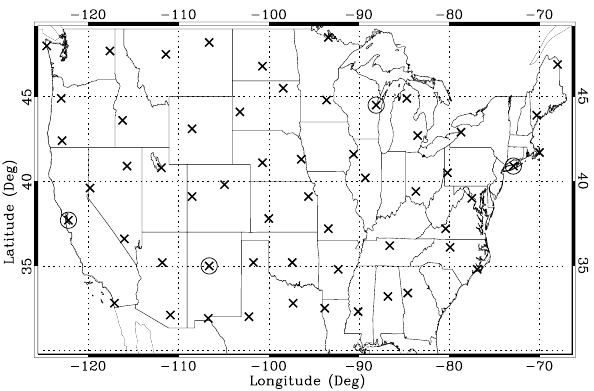
Fig. 1. Geographical locations of 56 Radiosonde stations used in this study. The stations with circles denote the positions of the sta- tions used in the case study. The stations are Oakland International Airport (37.7 ◦ N, 122.2 ◦ W), Albuquerque (35 ◦ N, 106.6 ◦ W), Green Bay (44.5 ◦ N, 88.1 ◦ W) and Brookhaven (40.9 ◦ N, 72.9 ◦ W),